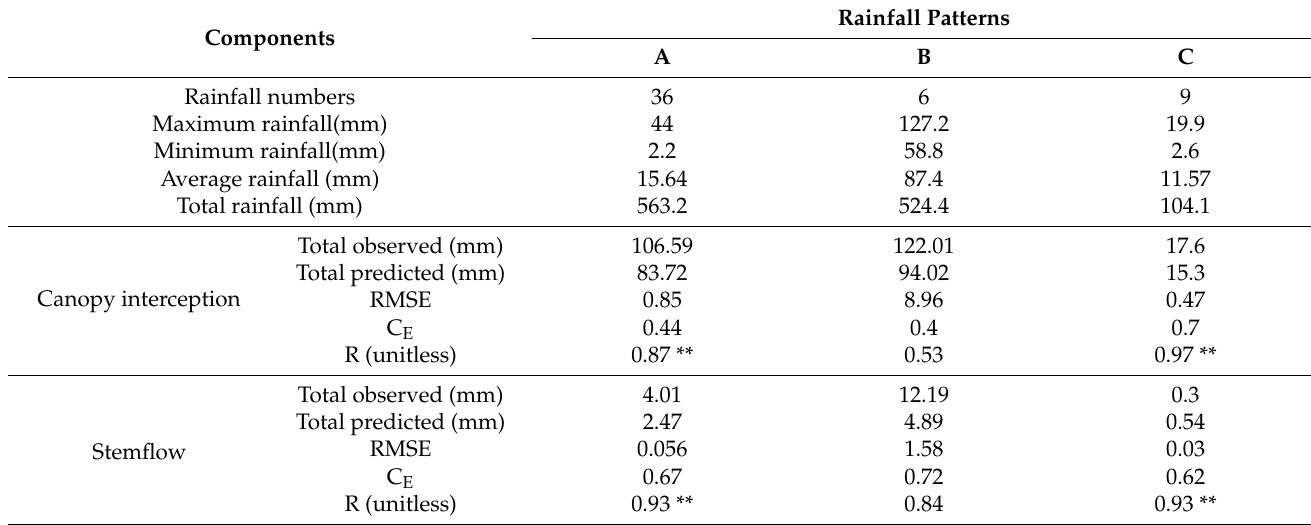
Table 6. A comparison of the total observed/predicted canopy interception and stemflow by the revised Gash